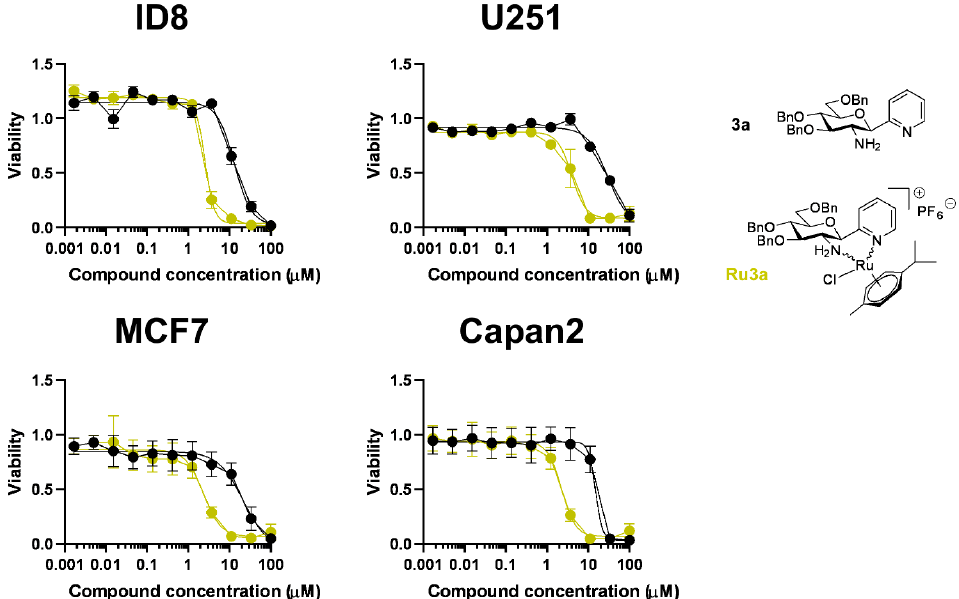
Figure 8. Assessment of free ligand 3a and complex Ru-3a for cytostatic activity in multiple carci- nomas. For this assay, 2 × 10 3 ID8, 3 × 10 3 U251, 3 × 10 3 MCF7 or 3 × 10 3 Capan2 cells were plated in 96 well plates. Cells were treated with the compounds in the concentrations indicated for 48 h; then, an SRB assay was performed. Data are represented as average ± SD from three biological replicates; individual assays were performed in duplicates. Values were normalized for vehicle- treated cells; absorbance for vehicle-treated cells equals 1. Statistical significance was assessed using a one-way ANOVA test comparing all values to the lowest concentration of a compound. Before the test, normality was assessed using the Shapiro–Wilk test, and the post hoc test was cho- sen accordingly. For better visibility, the p values and the distributions are presented in an Excel sheet available at https://figshare.com/s/9ec2a005e6b9e5874c07. Nonlinear regression was per- formed on the datasets indicated in Table 7. Table 7. The kinetic values of compounds 3a and Ru-3a in cancer cell lines other than A2780.